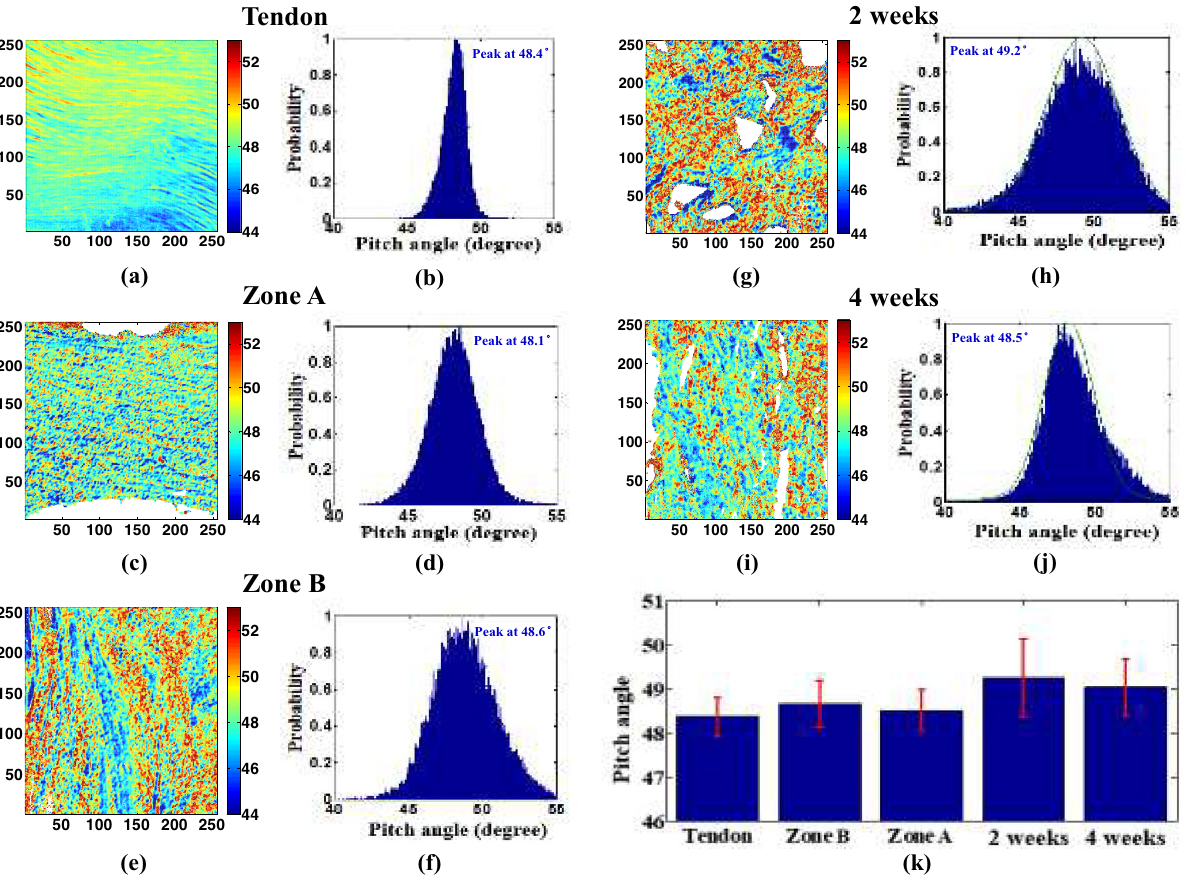
Figure 2. PA maps and corresponding PA histograms for ( a , b ) tendon, ( c , d ) cortical bone (Zone A), ( e , f ) articular cartilage (Zone B) of healthy bone control sample, and ( g , h ) bone fracture repair at 2 weeks, and ( i , j ) bone fracture repair at 4 weeks. ( k ) Averaged PA values for tendon, articular cartilage (Zone B), cortical bone (Zone A), and fracture repair at 2 weeks, and fracture repair at 4 weeks. Error bars represent standard error of mean. Image size is 50 × 50 μm 2 . The tendon and Zone A (COL I) have lower pitch angle as compared to Zone B (COL II), as observed in the colormaps ( a , c , e ). Similar decrease in the pitch angle can be observed for the colormap of 4 weeks ( i ) rich in collagen type I as compared to 2 weeks ( g ). The mean values of the healing